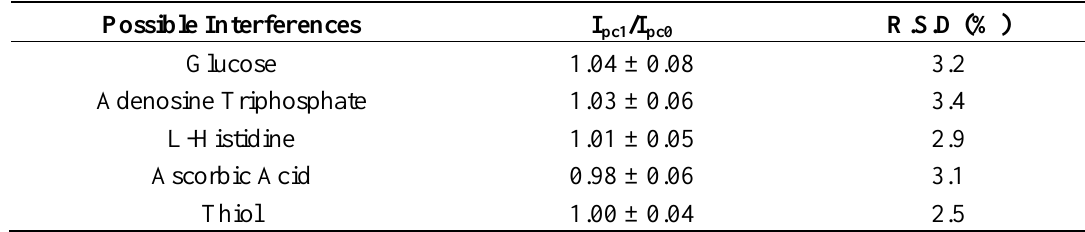
Table 2. Effects of possible interferences on the hydrogen peroxide biosensor. Possible